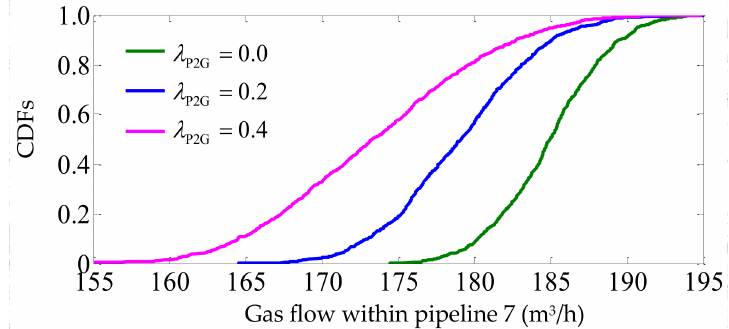
Figure 8. CDFs of gas flow within pipeline